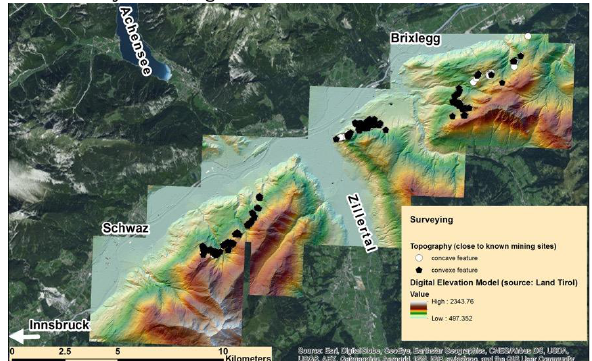
Figure 4. Surface structures identified in the high resolution elevation model of the province of Tyrol (Source: Land Tirol 2009)